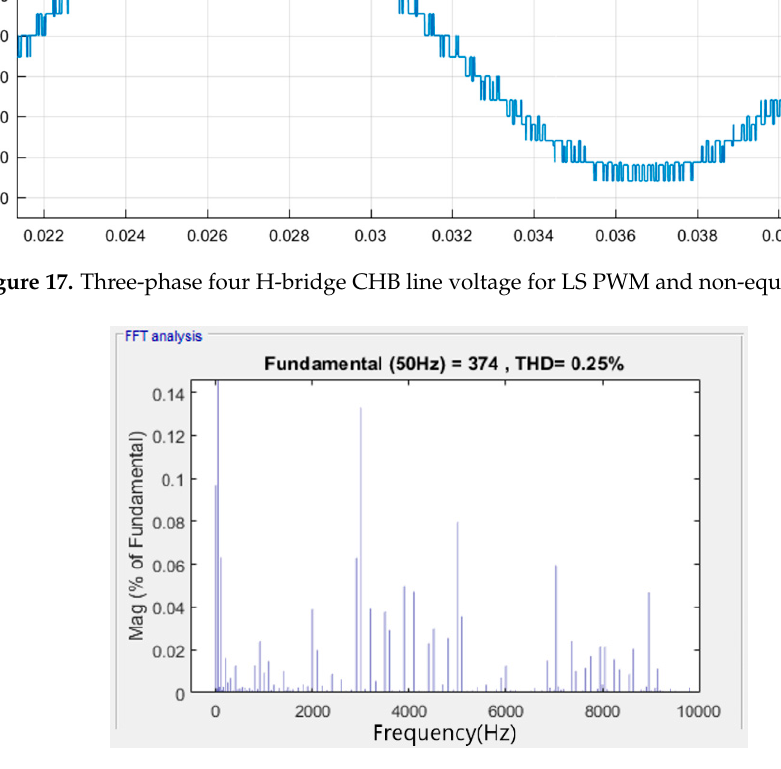
Figure 18. Three-phase four H-bridge CHB current THD for PS PWM and non-equal sources.